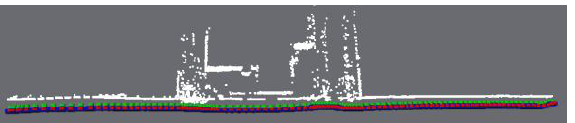
Figure 6. The photogrammetric block acquired during the survey (white points represent used tie points, while colored